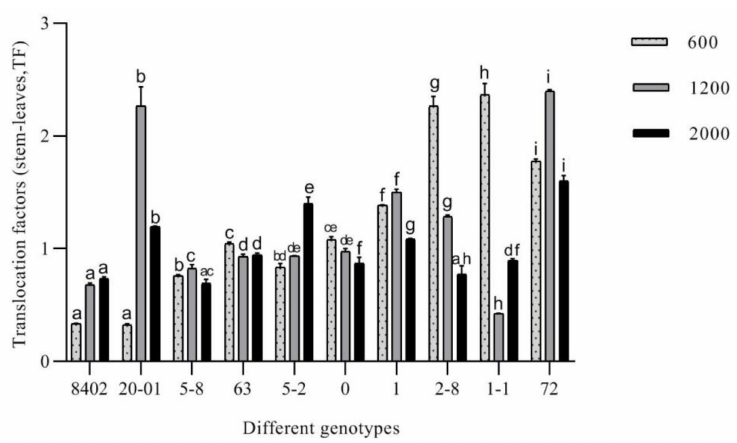
Figure 10. Stem–leaf transfer factors of C. bungei